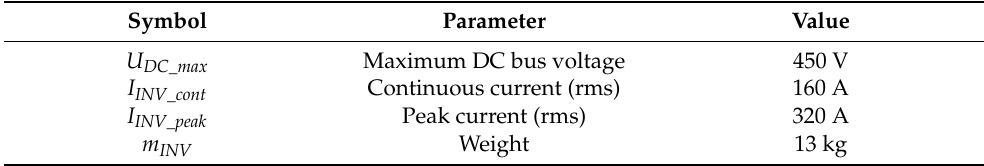
Figure 6. View of ( a ) a DC/AC IGBT air-cooled motor converter and ( b ) a DC/DC silicon carbide air-cooled fuel cell converter. Table 4. Parameters of the DC/AC motor converter.